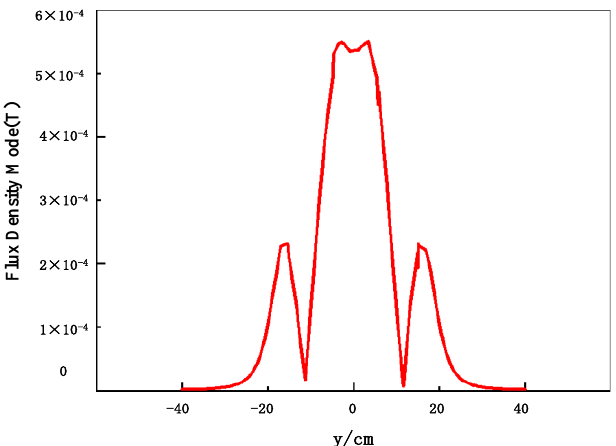
Figure 7. Magnetic field distribution on yoz plane coupling center line.